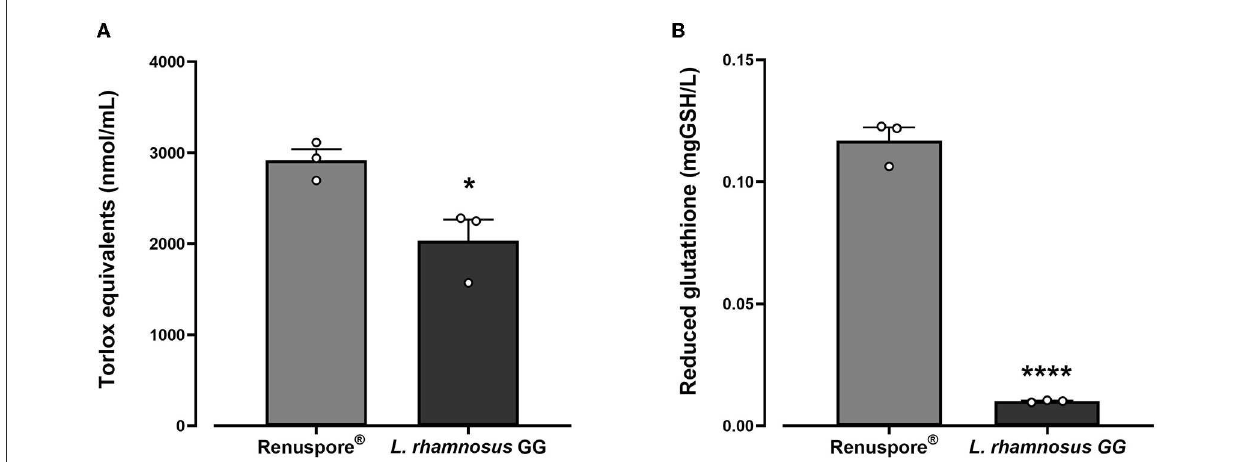
FIGURE1 Renuspore ® had significantly increased levels of (A) Trolox equivalents and (B) reduced glutathione GSH compared with L. rhamnosus GG. The results show average concentration ( n = 3) ± standard error. Significant difference observed between Renuspore ® and L. rhamnosus GG: * p < 0.05 and **** p < 0.0001. The results were statistically analyzed using one-way analysis of variance (ANOVA) (biological replicates n = 3) followed by Tukey’s multiple comparison test using GraphPad Prism v.9.